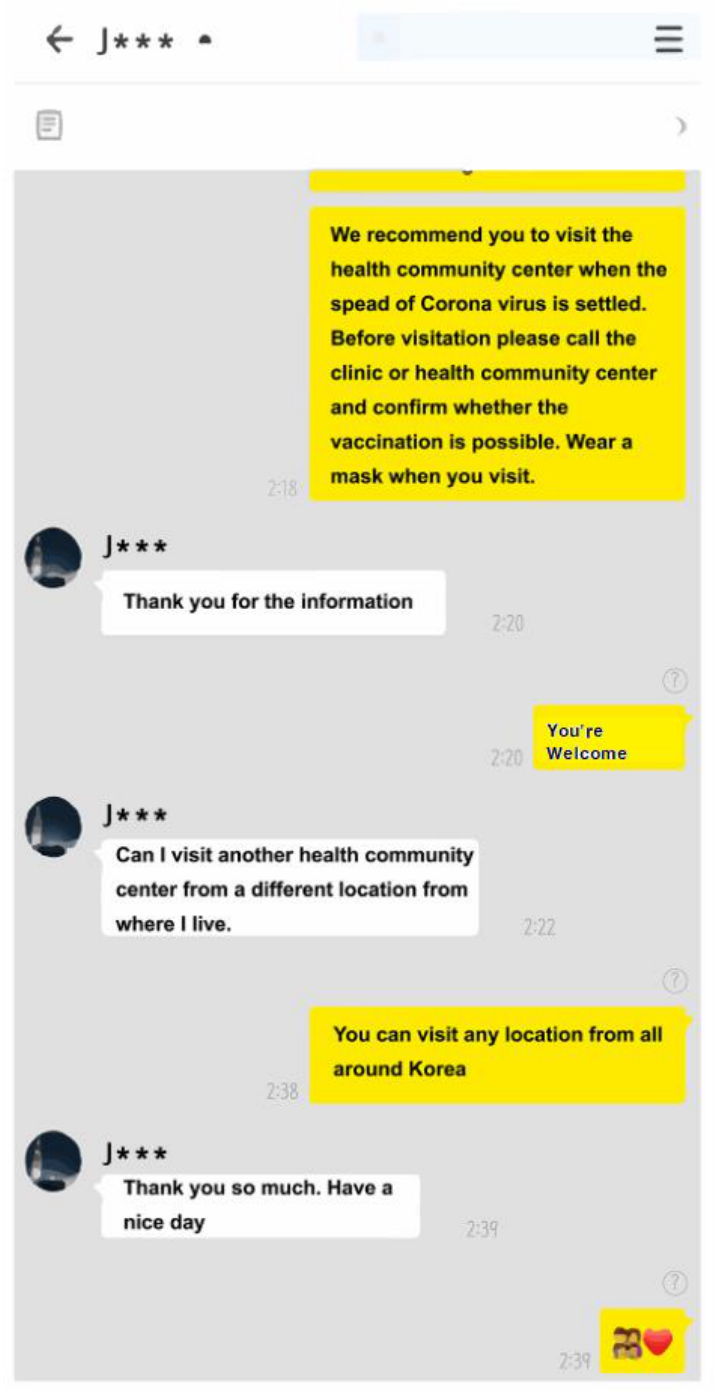
Figure 2. Immunization inquiries about COVID-19.